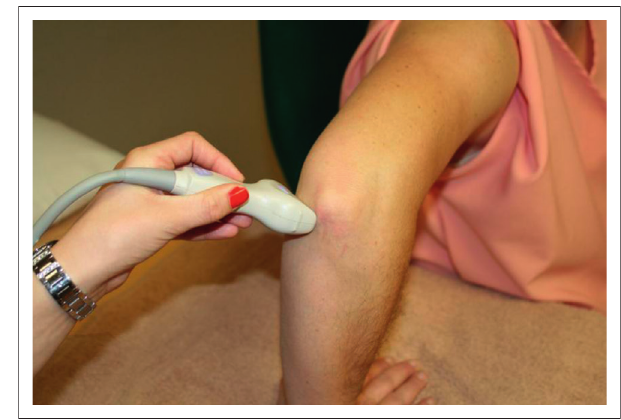
Source : T. Roodt. FIGURE 4: Ultrasound image of the normal ulnar nerve in a longitudinal plane at the level of the medial epicondyle with the elbow in flexion.